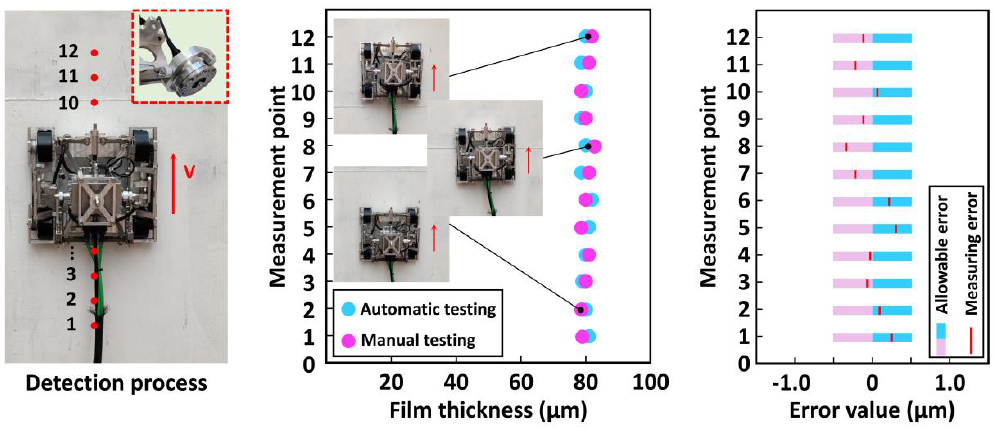
Figure 14. Measurement experiment of film thickness.